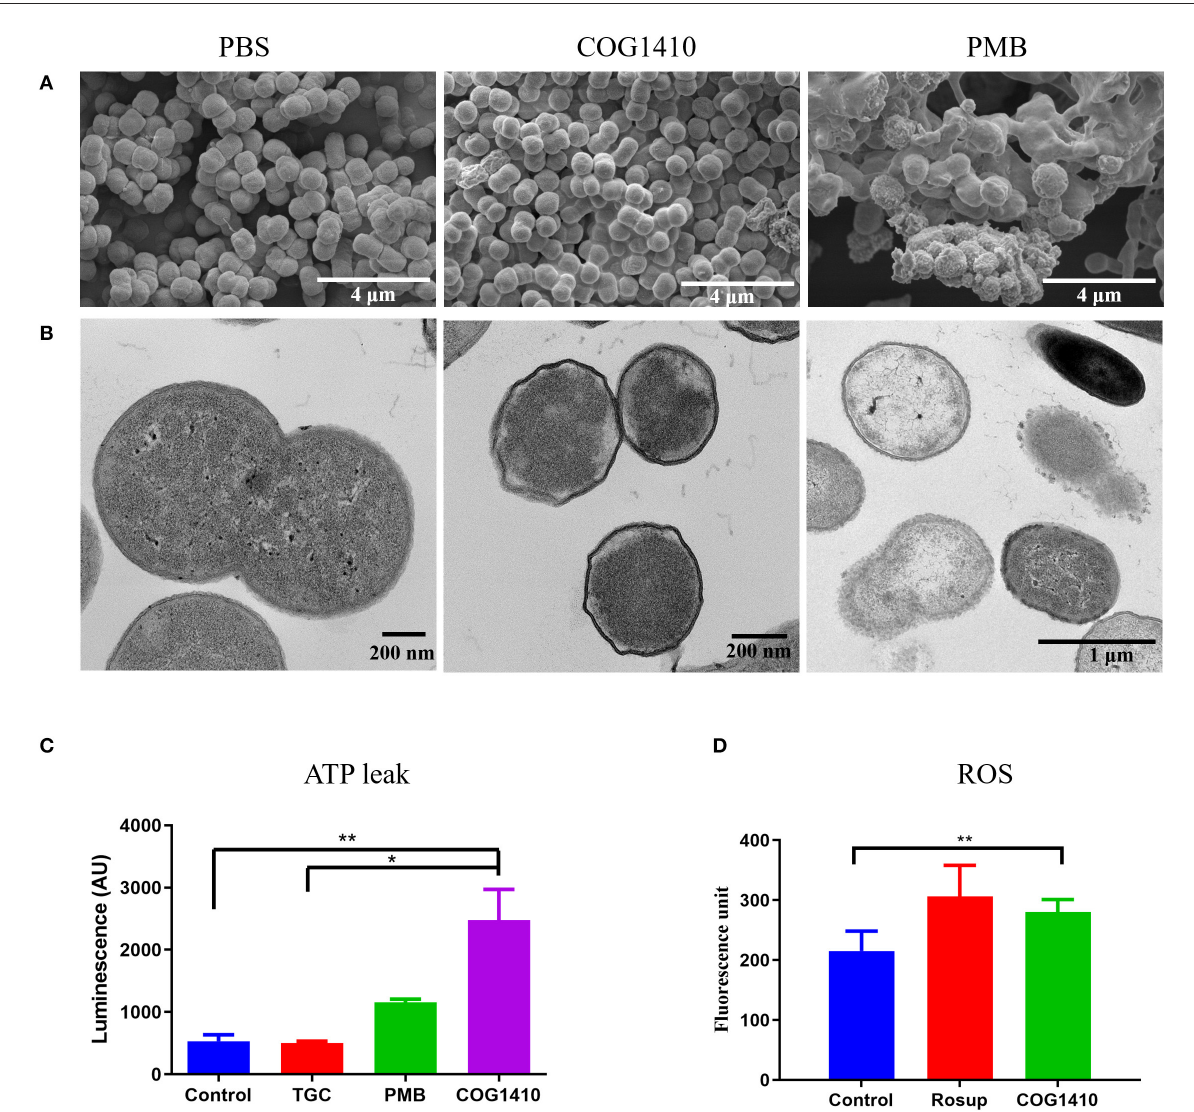
FIGURE3 COG1410 treatment permeabilized cell membrane of PDR A. baumannii. SEM (A) and TEM (B) observation of A. baumannii YQ4 exposed to 1 × MIC COG1410 or 1 × MIC polymyxin B. The cells in PBS were negative control. (C) The effect of 1 × MIC COG1410 on ATP release from